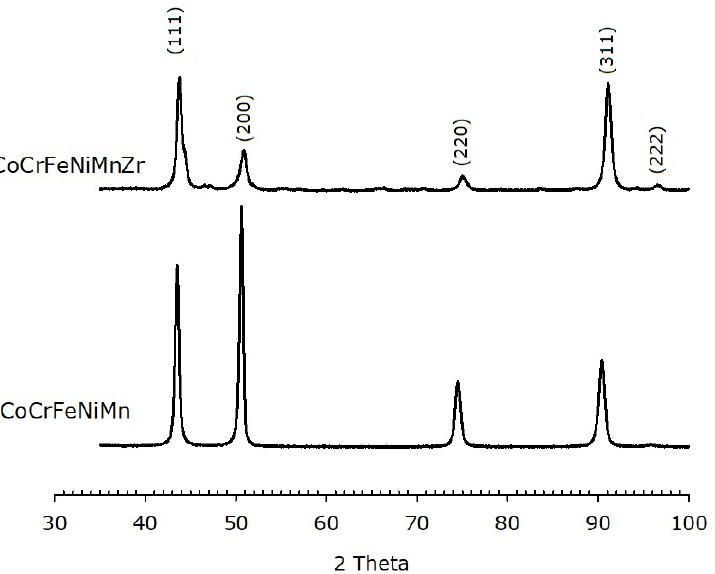
Figure 6. XRPD data of as-cast HEAs, with and without Zr modifier, showing an FCC structure. The Miller indices of the lattice planes are indicated.